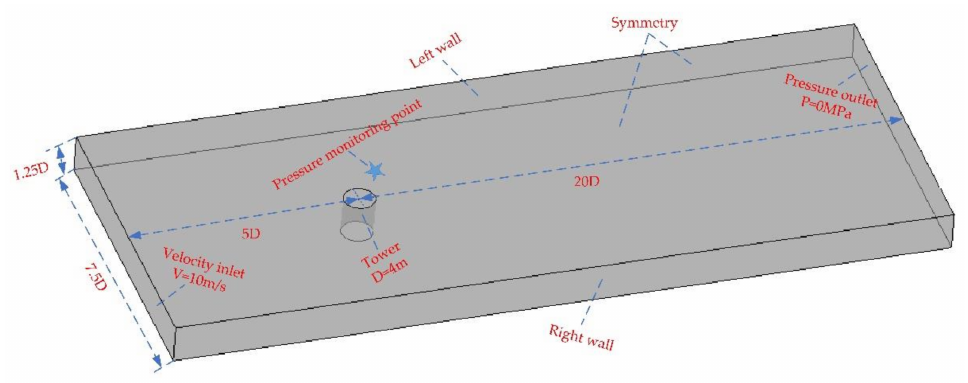
Figure 4. The definitions of the computational fluid